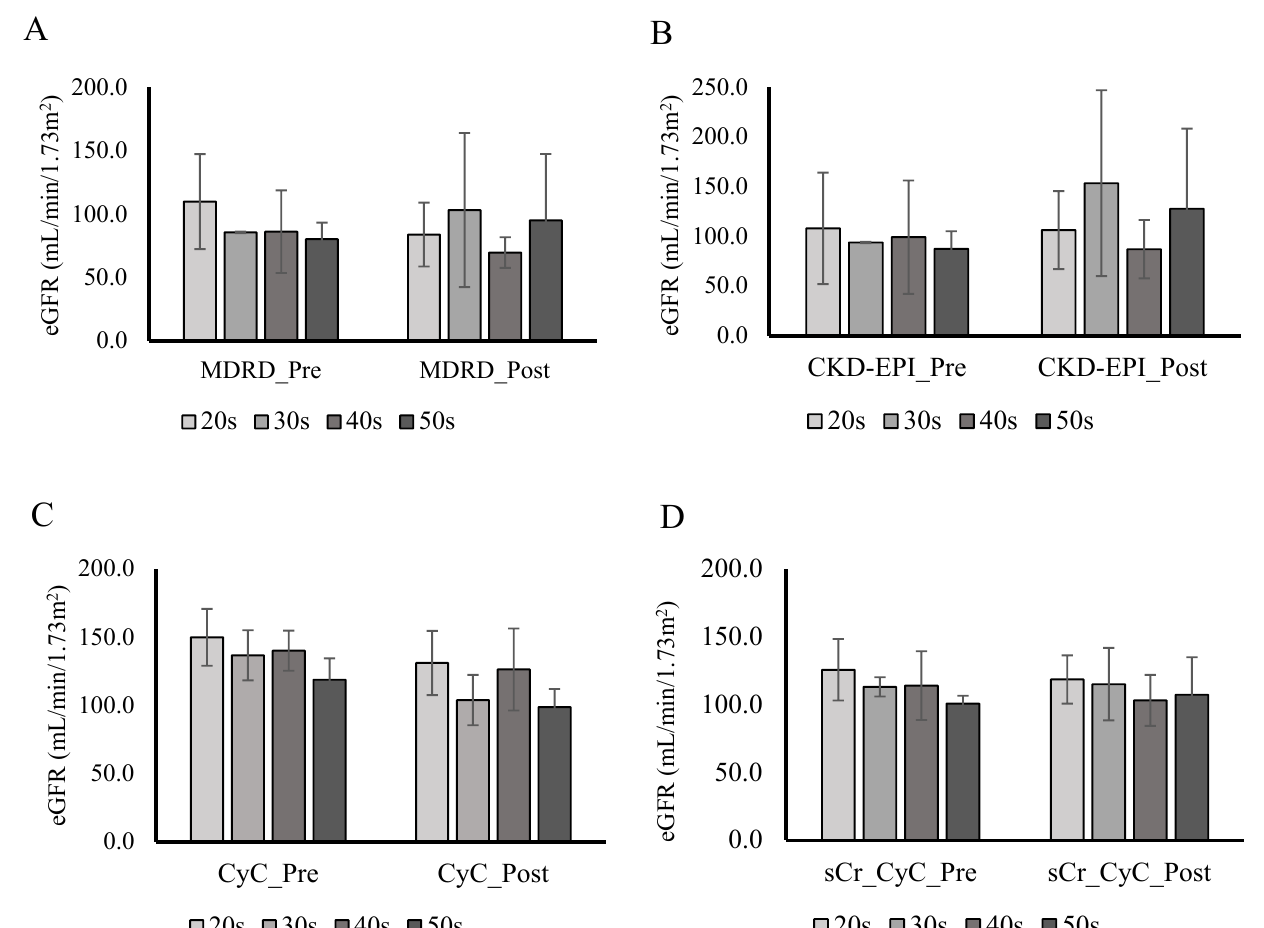
Figure 1. Age group comparison of eGFR ( A – D ). Abbreviations: Cystatin C (CyC), chronic kidney disease–epidemiology (CKD_EPI), estimated glomerular filtration rate (eGFR), Female (F), Male (M), Modification of Diet in Renal Disease (MDRD), serum creatinine (SCr), urine creatinine (uCR), and urine epidermal growth factor (uEGF). 20s—21 individuals (8 M/13 F), 30s—3 individuals (3 M), 40s—11 individuals (5 M/6 F), and 50s—4 individuals (2 M/2 F). All data are presented as mean + SD. There was no significant differences pre—to post-exercise.